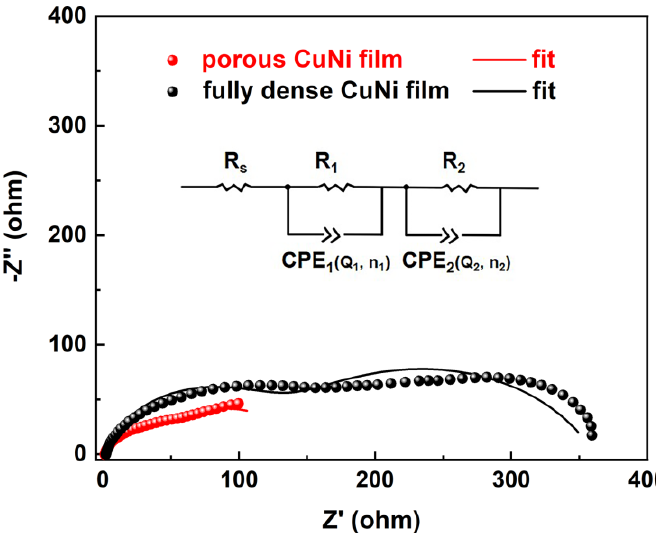
Figure 9. EIS Nyquist plots of porous and fully dense CuNi films in 1 M KOH solution. The inset is the equivalent circuit. R s represents the electrolyte resistance, R 1 is the charge transfer resistance, R 2 is the diffusion transfer resistance, and CPE is the conventional double-layer capacitance to account for non-uniform diffusion.